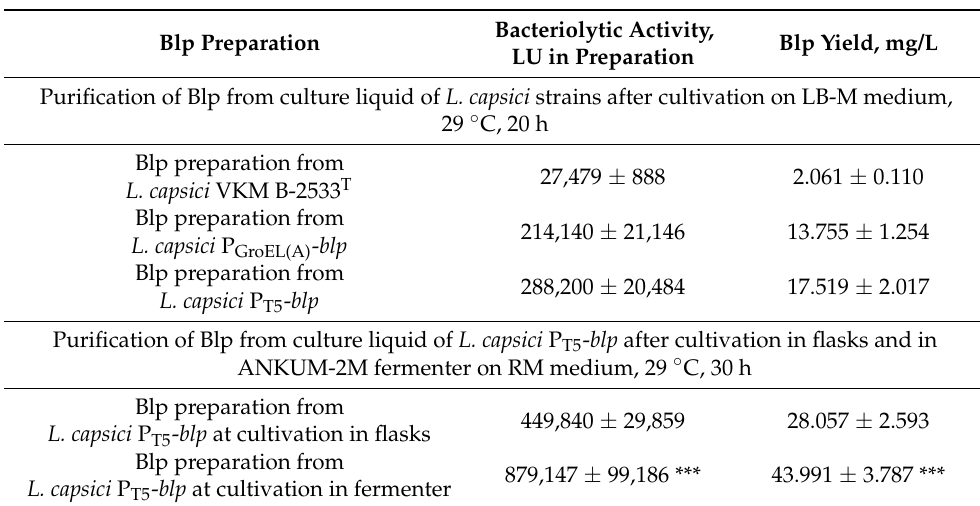
Table 2. Comparative characterization of Blp homogeneous